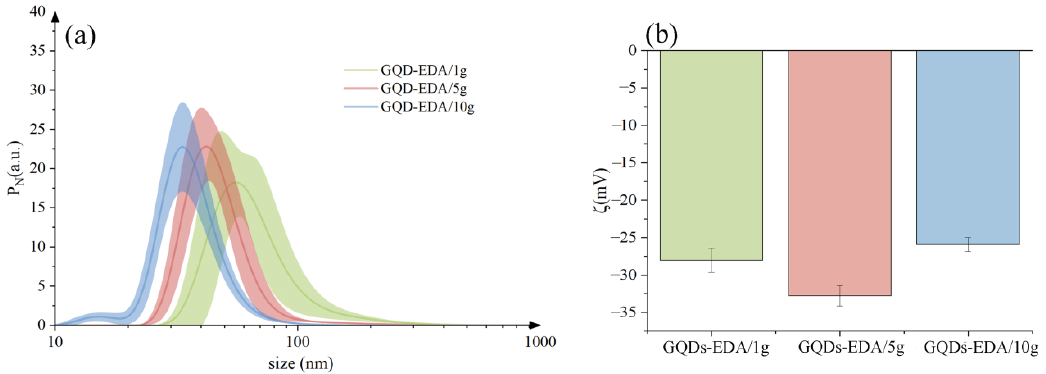
Figure 2. Number-weighted size distributions of the three GQDs compounds measured with DLS ( a ) with the corresponding ζ -potentials ( b ).